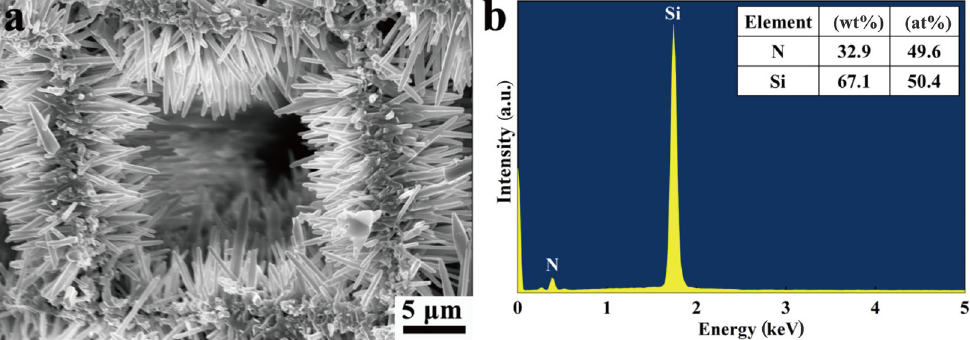
Fig. 3 (a) Enlarged SEM image of β -Si 3 N 4 nanowhisker arrays on the microchannel walls; (b) EDS patterns of elemental